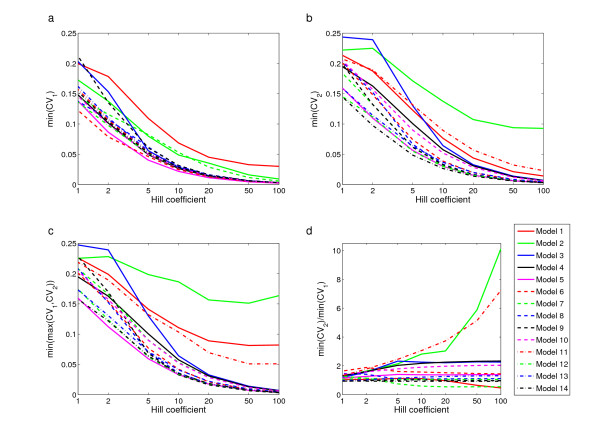
The coefficient of variation as function of the Hill coefficient for the most robust parameter sets for gene 1 and 2 across all 14 models. (a)-(b): Minimum of CV1k and CV2k, respectively, over all 81 parameter sets. (c): CVminmax as function of the Hill coefficient for each of the 14 models. An explanation for the remarkably high values for Models 1, 2, and 11 for high Hill coefficient values is given in the text. (d) The ratio of minimum of CV2k to minimum of CV1k as function of the Hill coefficient for each of the 14 models.